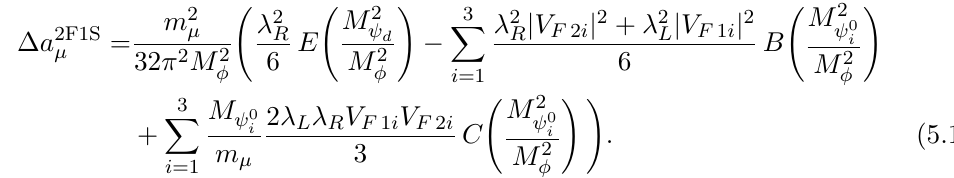
and fermion doublet d